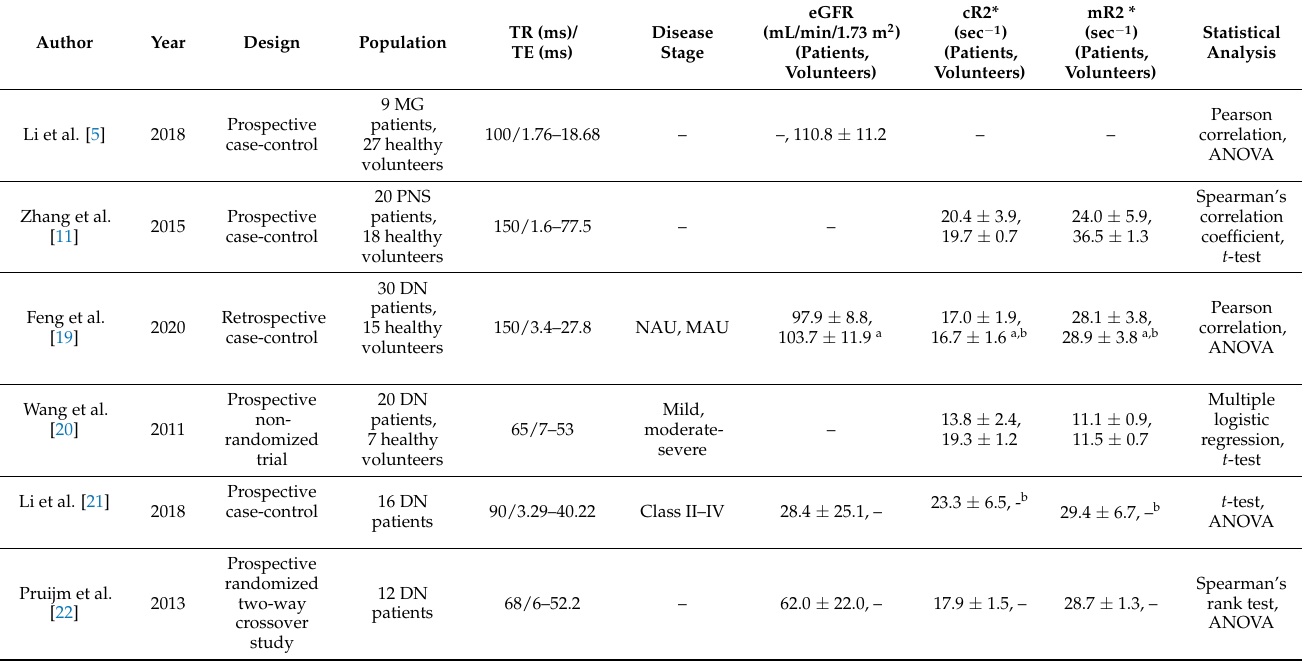
Table 1. Summary of BOLD MRI studies. MG = membranous glomerulonephritis, PNS = primary nephrotic syndrome, DN = diabetic nephropathy, LN = lupus nephritis, NAU = normal to mildly increased albuminuria, MAU = moderately increased albuminuria, TR = repetition time, TE = echo